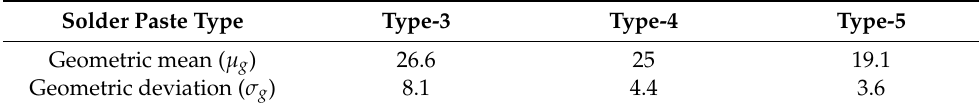
Table 1. Log-normal fit parameters for different types of solder pastes.